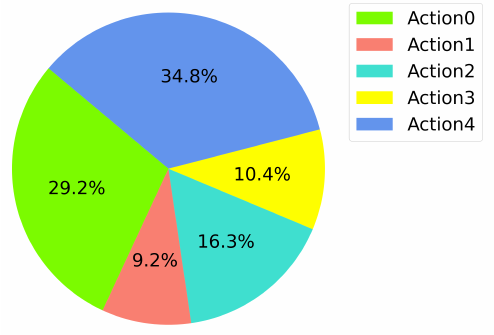
Figure 20. DQfD Action Frequency.